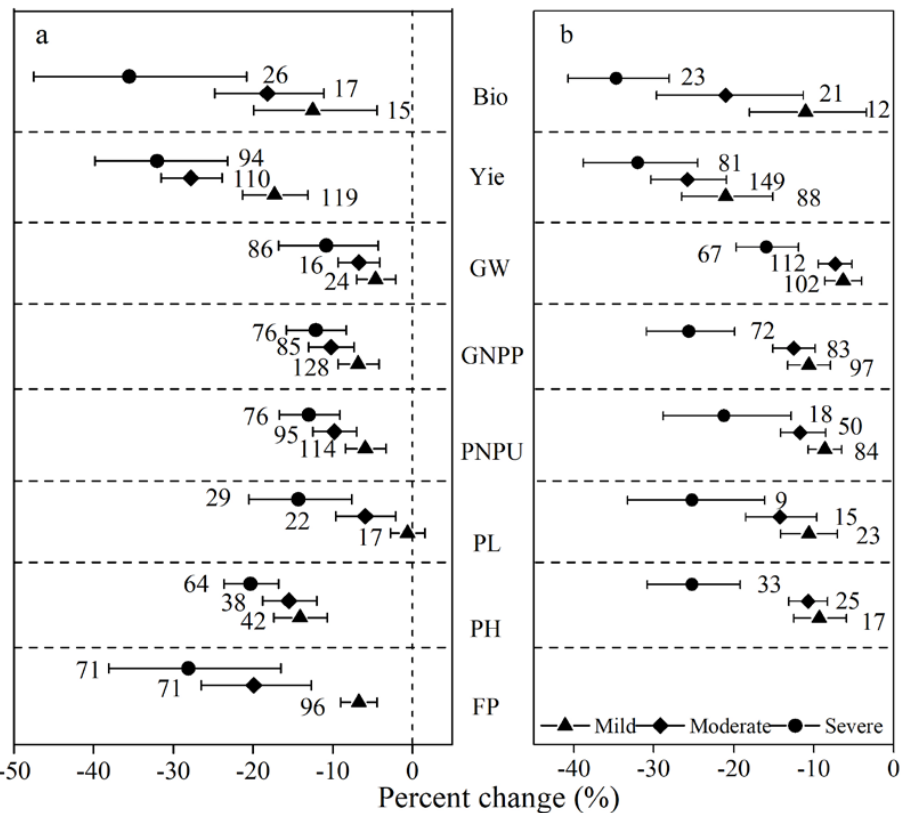
Figure 2. Response of rice and wheat to drought under different stress intensities. Numbers near the symbols specify the number of data points and the error bars indicate a 95% confidence interval. Abbreviations for the agronomic traits are described in Table 2 ( a ) Rice, ( b ) Wheat.